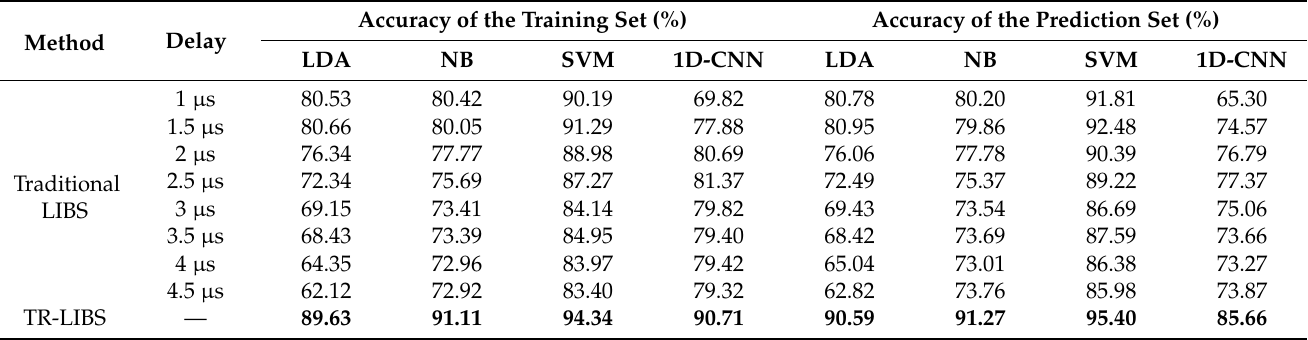
Table 2. Classification accuracy of traditional LIBS and TR-LIBS combined with machine learning models and deep learning models on the training and prediction